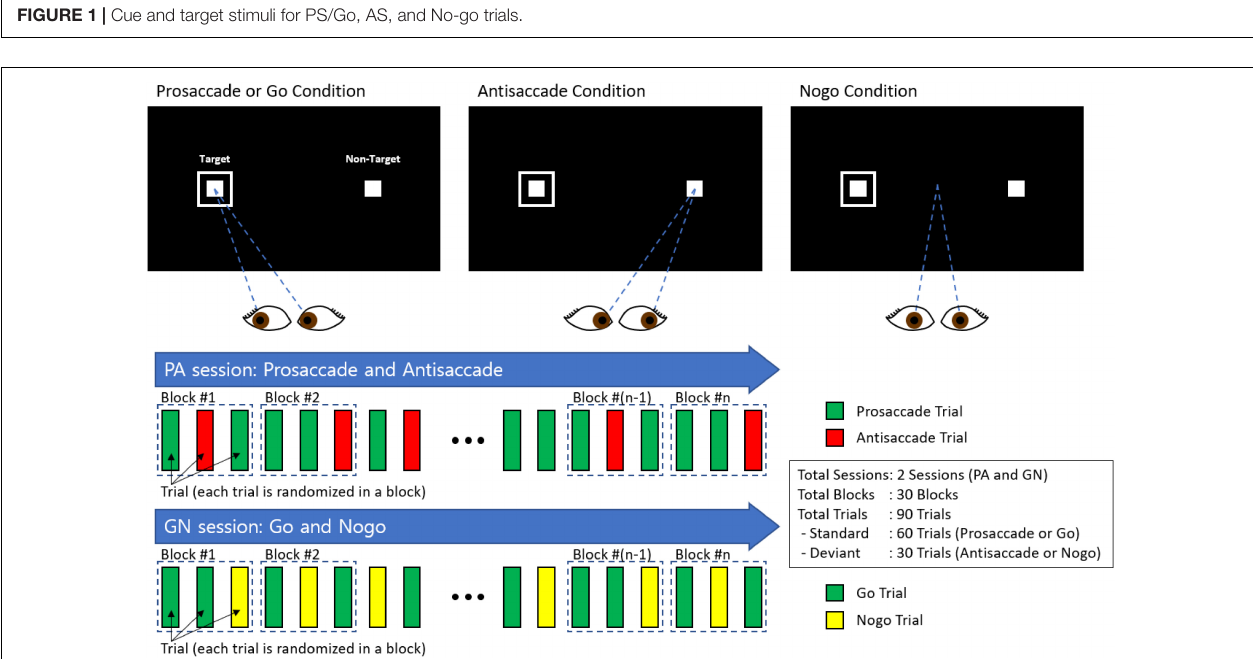
FIGURE 1 | Cue and target stimuli for PS/Go, AS, and No-go trials.